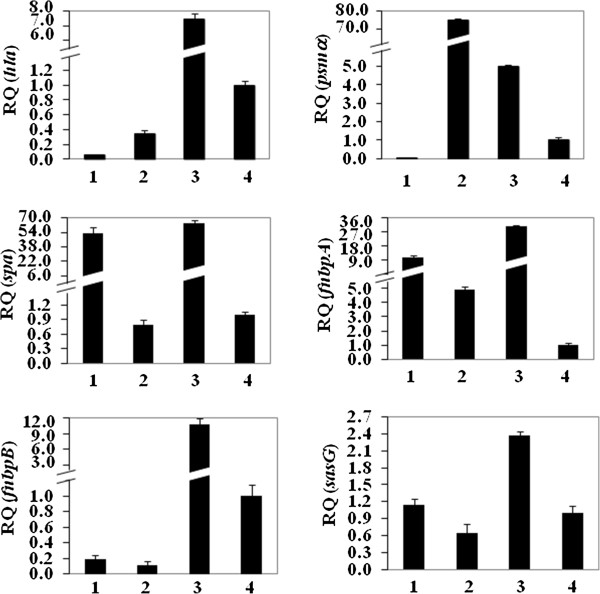
Transcriptional levels of virulence-associated genes determined by RT-qPCR, using ΔΔCT comparative method. (1) USA400-related isolates 08–008 (agr-dysfunctional) and (2) 96/05 (agr-functional). (3) BMB9393 was used as a control and (4) RN6390B as calibrator. RQ: Relative quantity.